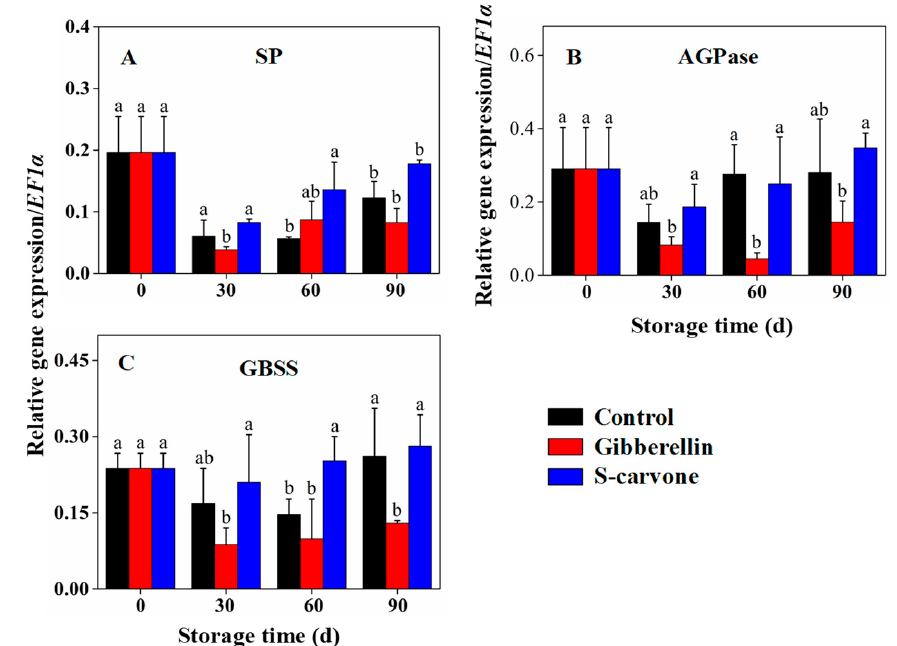
Figure 5. Effects of gibberellin and ( S )-carvone on gene expression/ EF1a in potato tubers during 4 °C low temperature storage. ( A ) Gibberellin and ( S )-carvone effect on expression of SP . ( B ) Gibberellin and ( S )-carvone effect on expression of AGPase . ( C ) Gibberellin and ( S )-carvone effect on expression of GBSS . The error bars represent the standard errors. Means with the same letters are not statistically different according to the least significant difference test at p < 0.05.